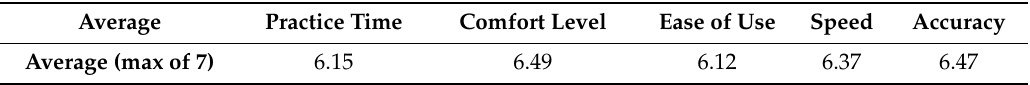
Table 4. User feedback from posttest